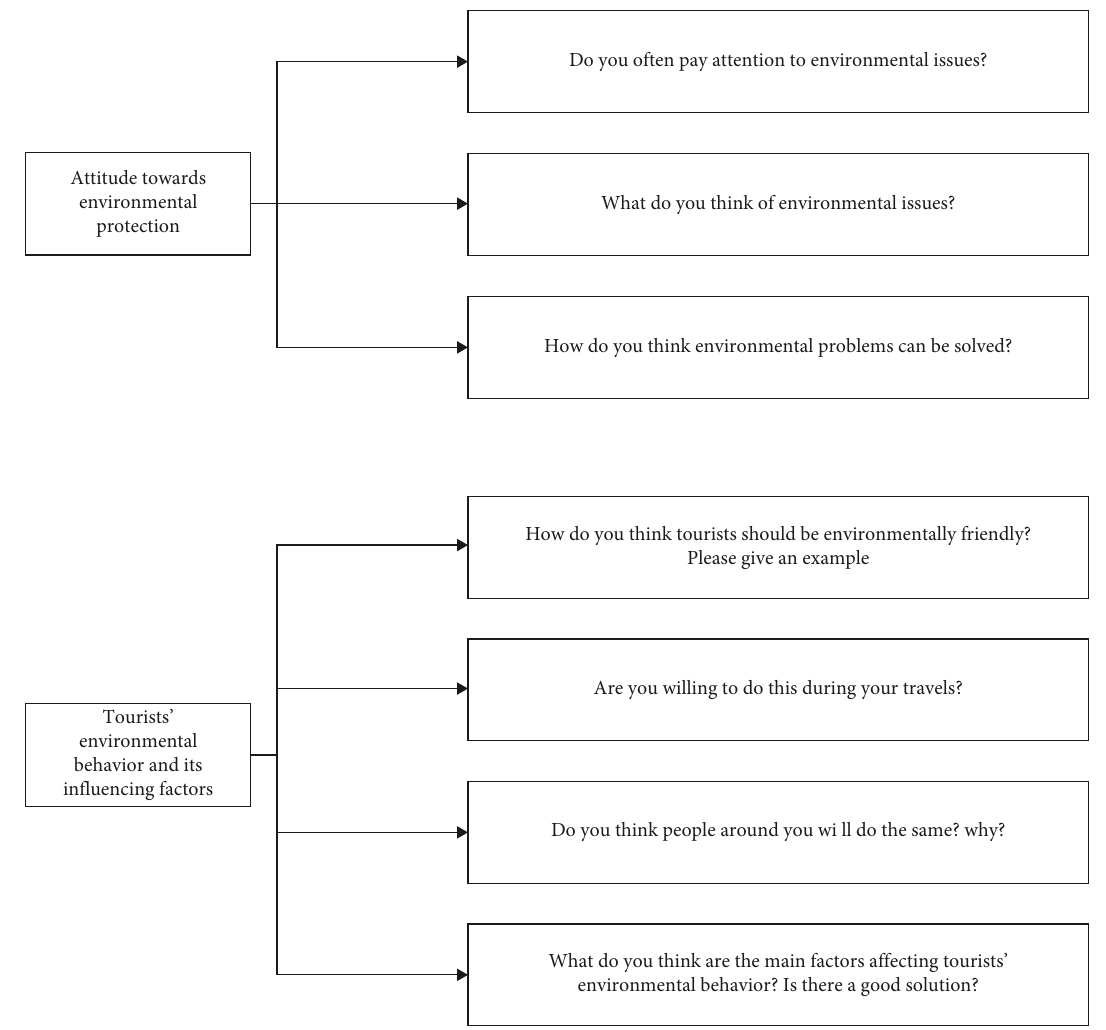
Figure 1: Questions to be asked in the interview. Table 1: Process of probability adjustment for the willingness to invest in environmental protection technology. Investment in environmental protection